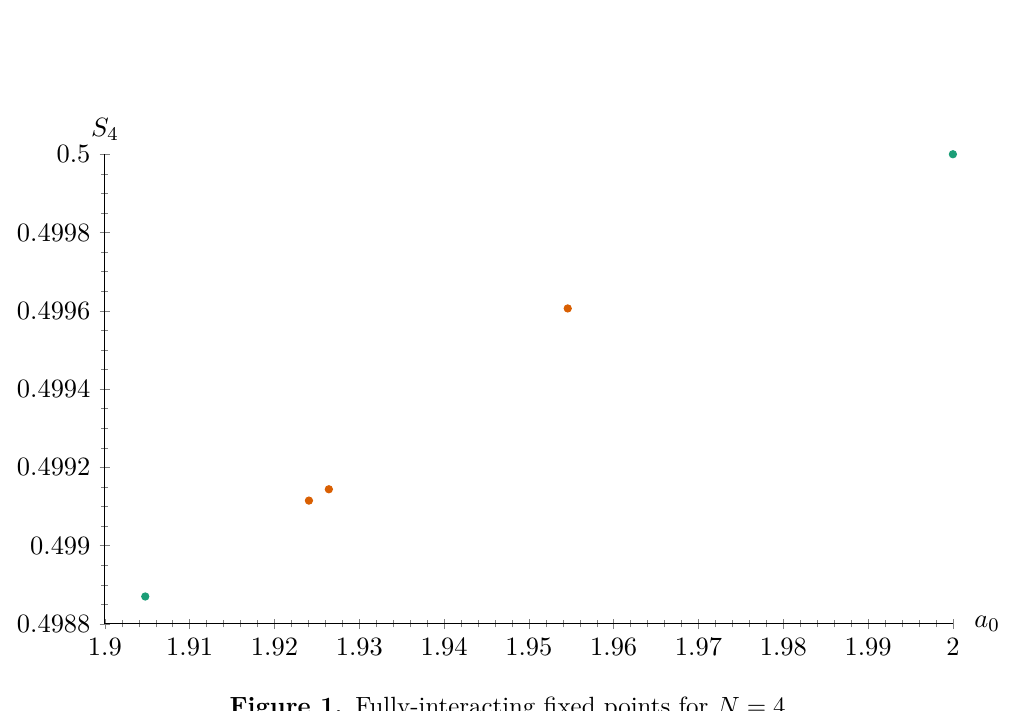
Figure 1. Fully-interacting fixed points for N = 4 .